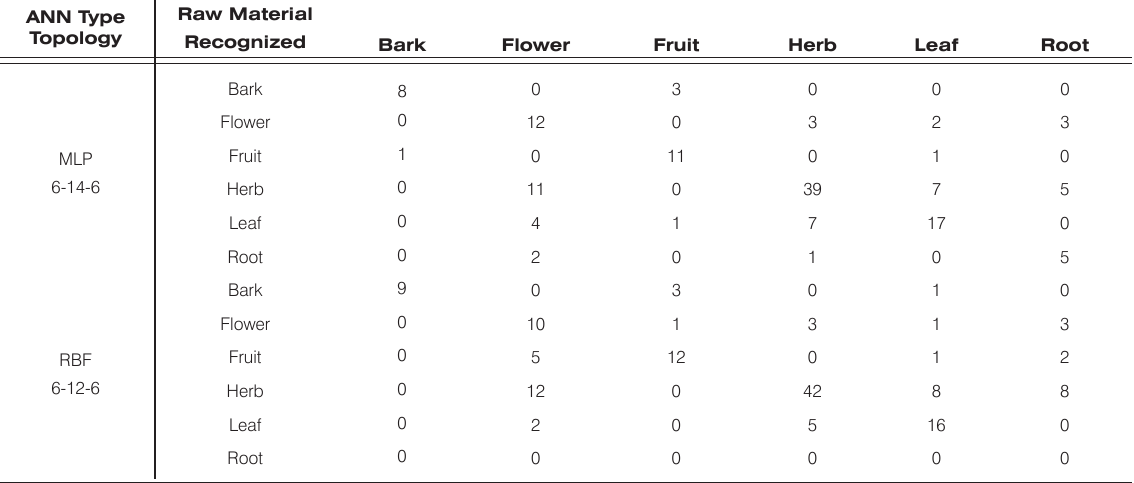
Table 3. Confusion matrices. ANN Type Topology